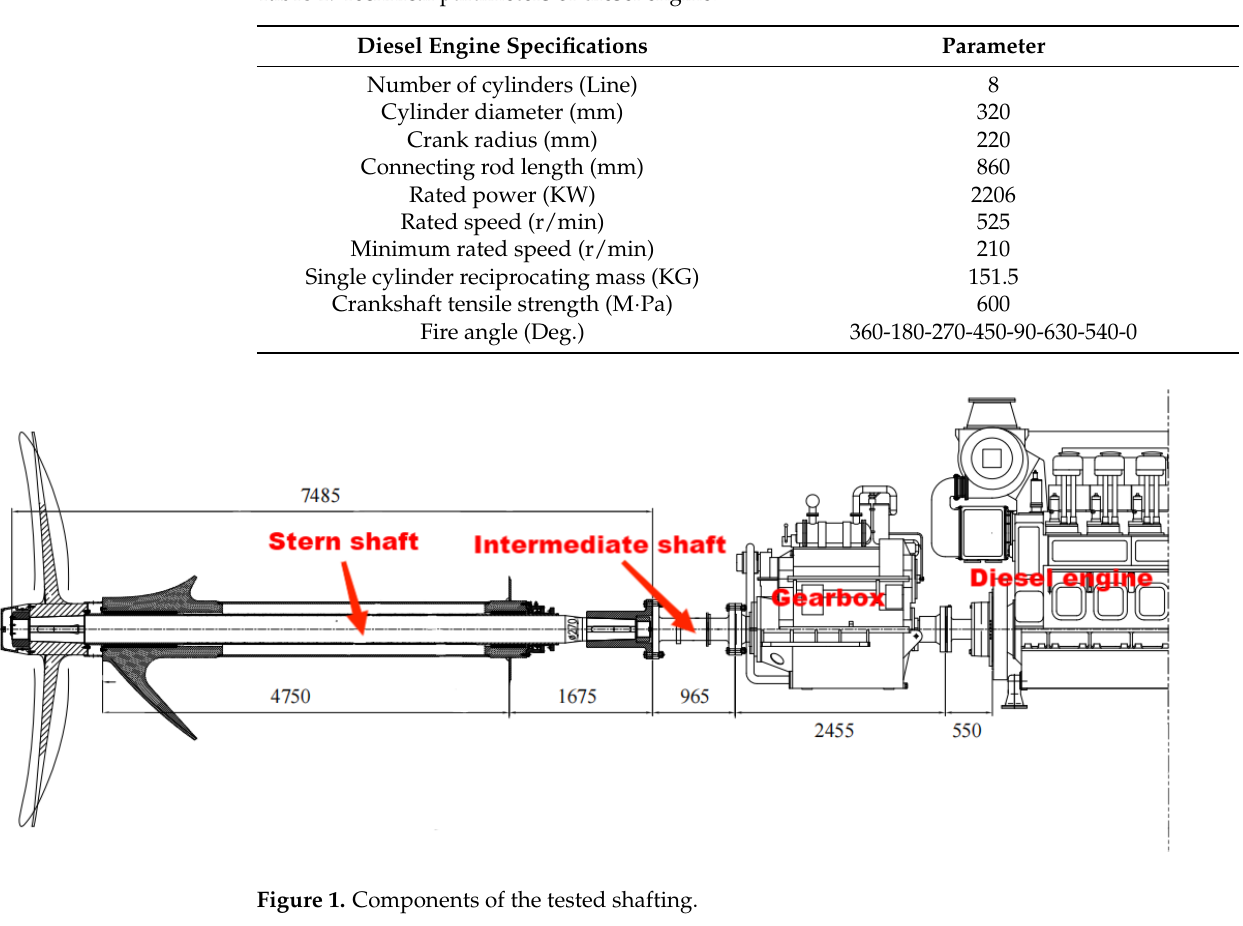
Table 1. Technical parameters of diesel engine.